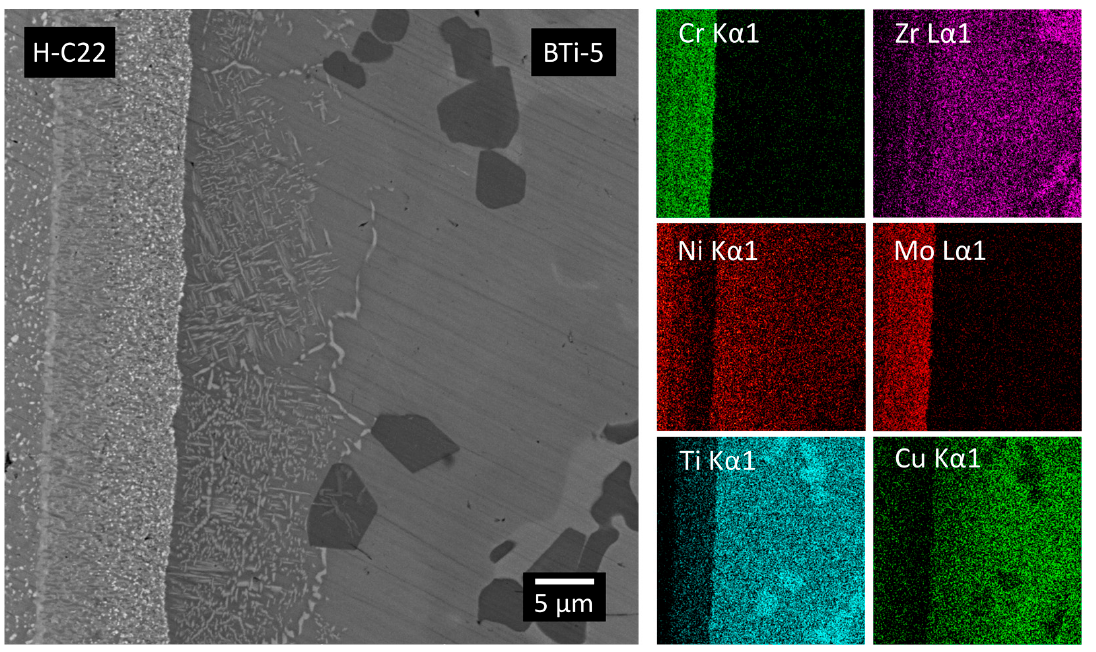
Figure 10. FE-SEM BSE images of the interface of Hastelloy C22 ® and the filler metal in a circular H-C22/Al 2 O 3 joined sample produced at 900 ◦ C for 12 min in a high vacuum furnace and 750 ◦ C for 20 min. The EDS maps of the main elements of the two materials.